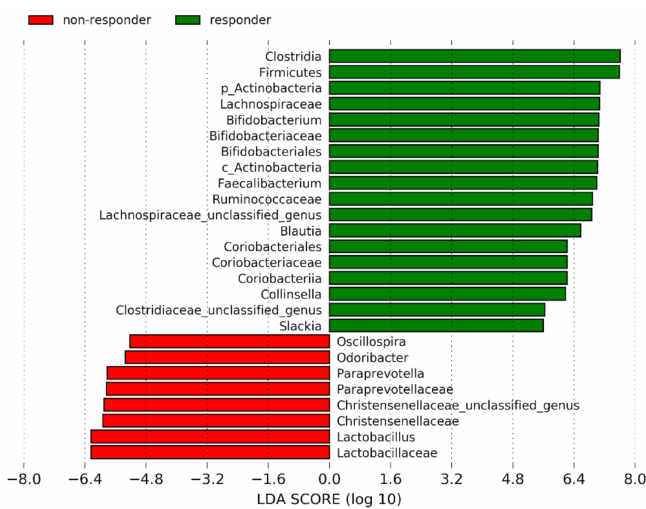
Figure 4. Linear discriminant analysis (LDA) scores of responders and non-responders in the FMT group of patients with active left-sided UC on di ff erent taxonomical levels (phylum, class, order, family, genus) for all sampling points including baseline. Actinobacteria phylum and class are distinguished using shortcuts p and c,